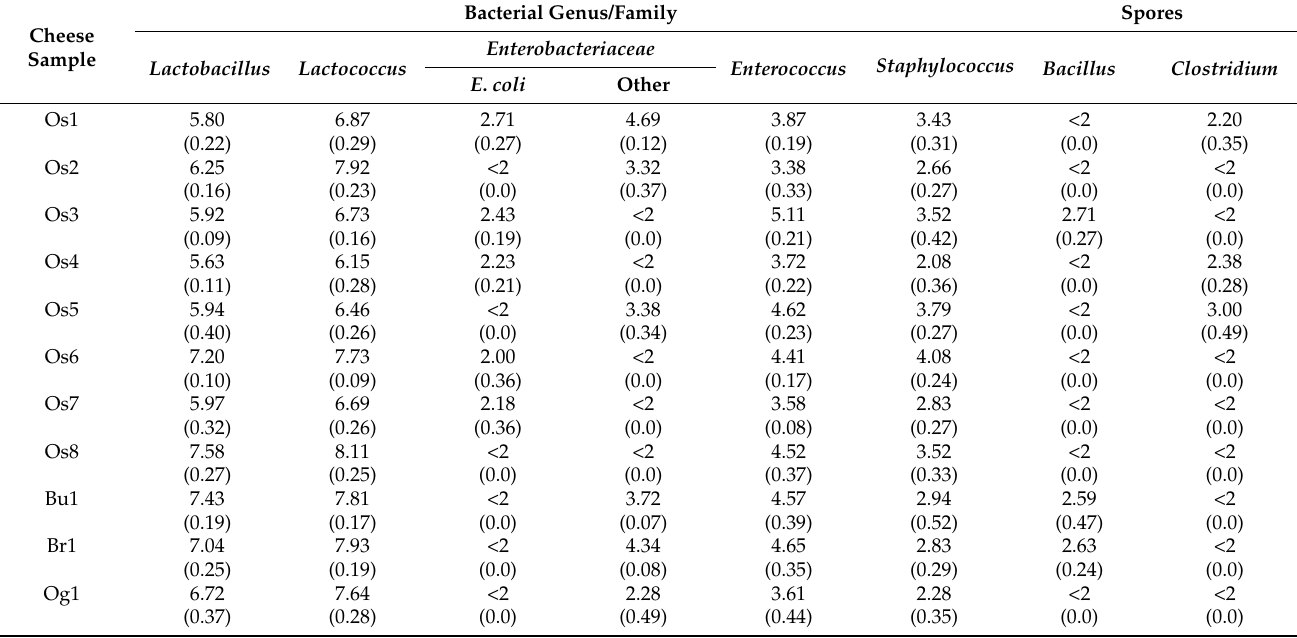
Table 4. Counts (log CFU/g) of bacteria in cheeses made from raw cow, ewe, and goat milk. Cheese